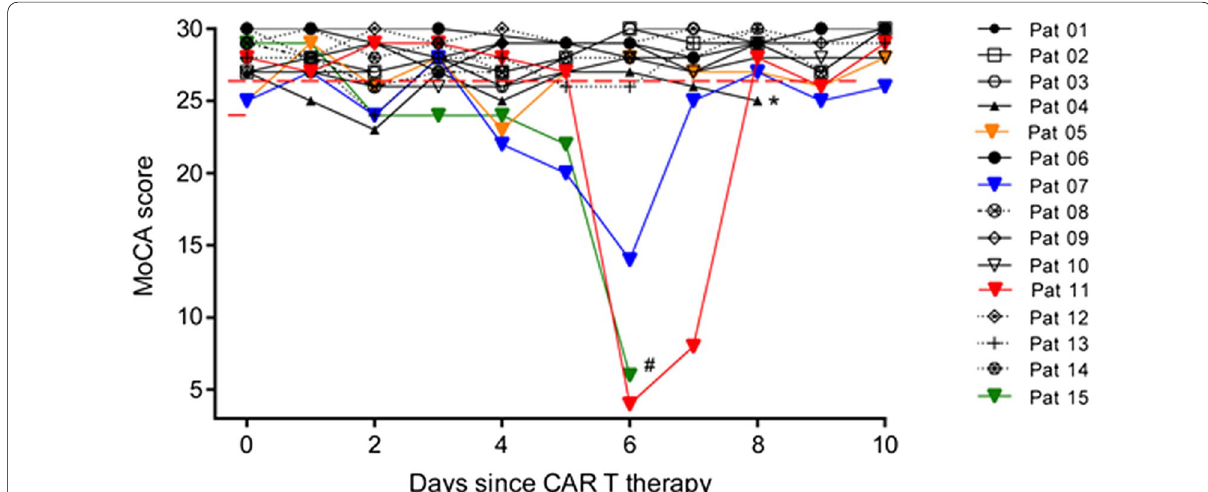
Fig. 2 MoCA test results during 10 days monitoring period. All 15 patients were treated with CAR T cell therapy. Except for patient 4 and patient 15 all patients were subjected to a daily MoCA test until the 10th day after therapy. MoCA: Montreal Cognitive Assessment. Pat: patient. *Patient 4 was intubated due to severe CRS on day 8, no further testing; # Patient 15 was transferred to palliative care unit on day 7, no further